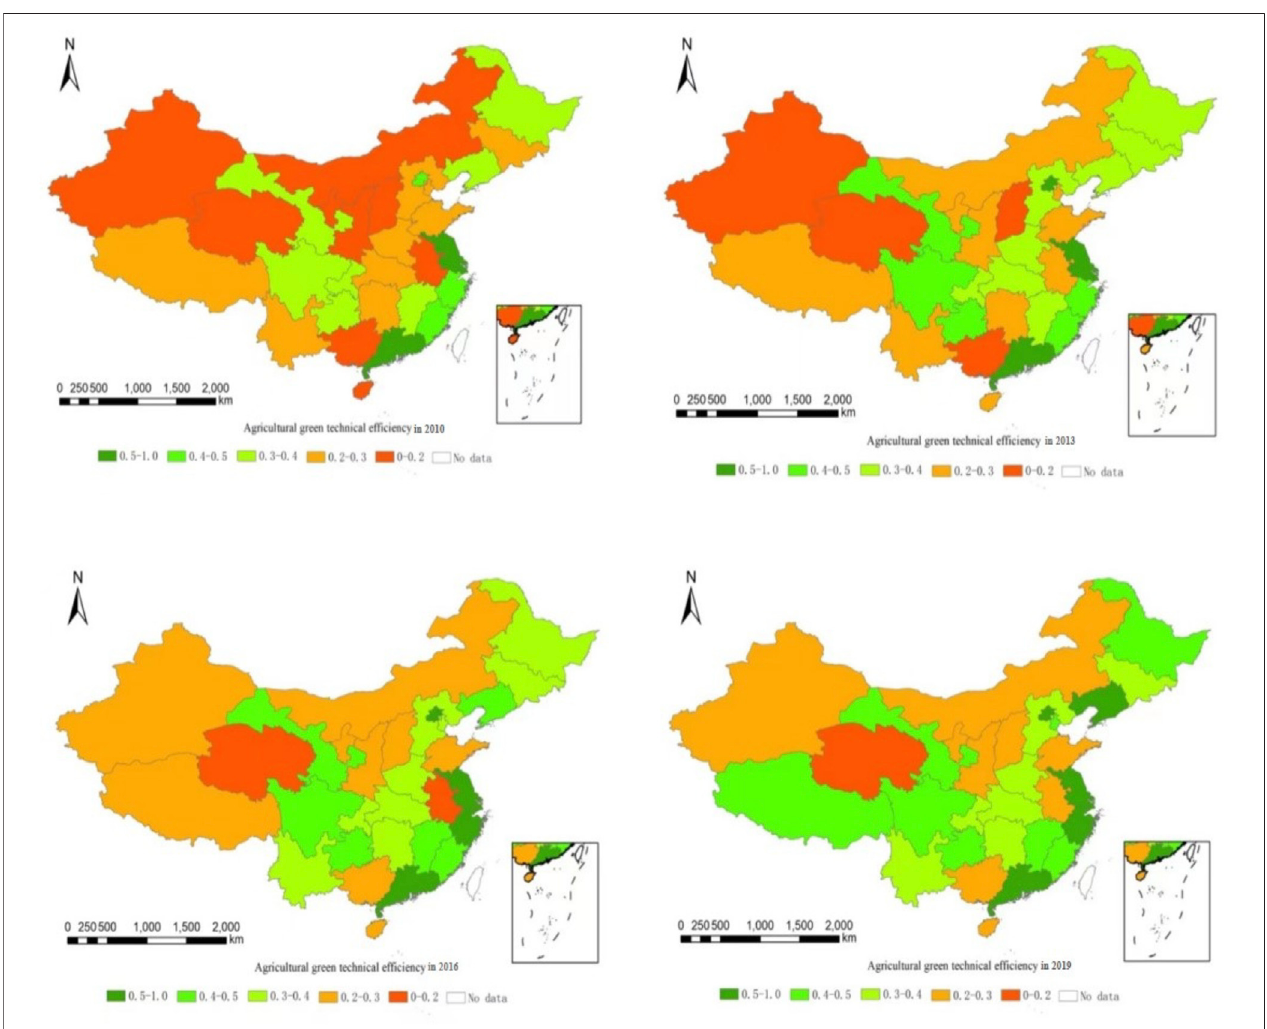
FIGURE 2 | Spatial distribution of the agricultural green development index (AGDI) in crucial years in China.